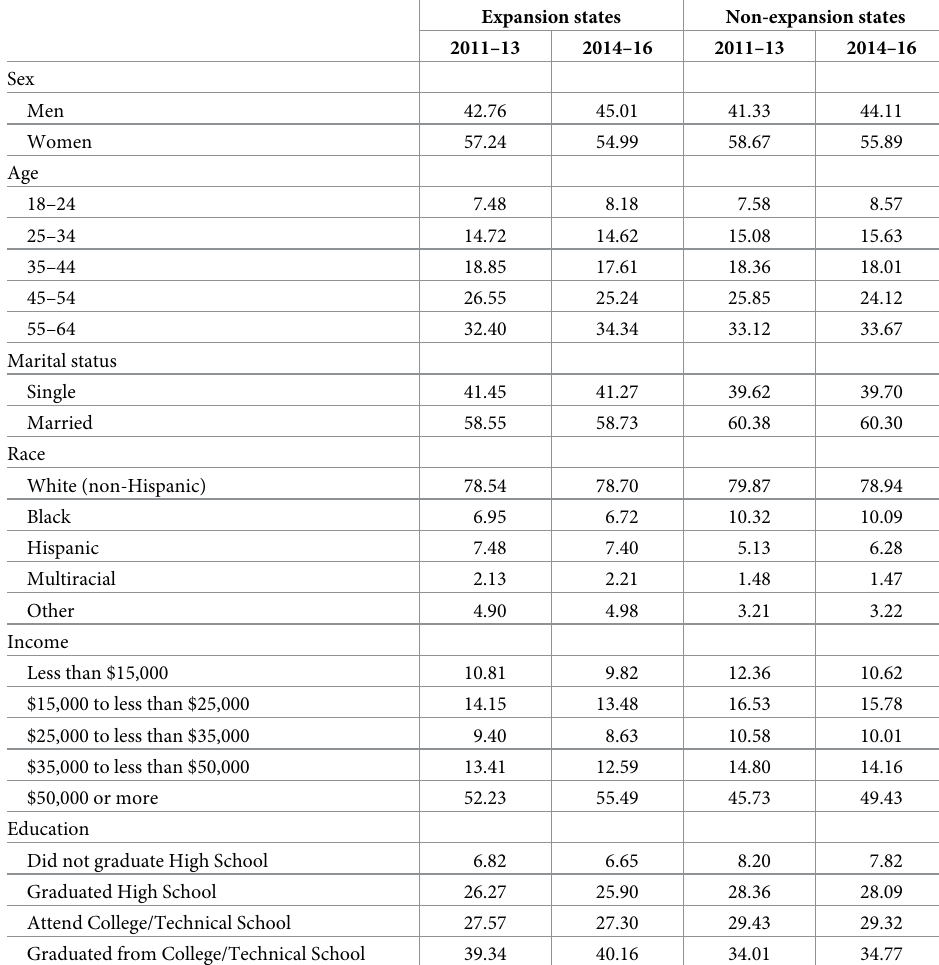
Table 1. Demographic of the study